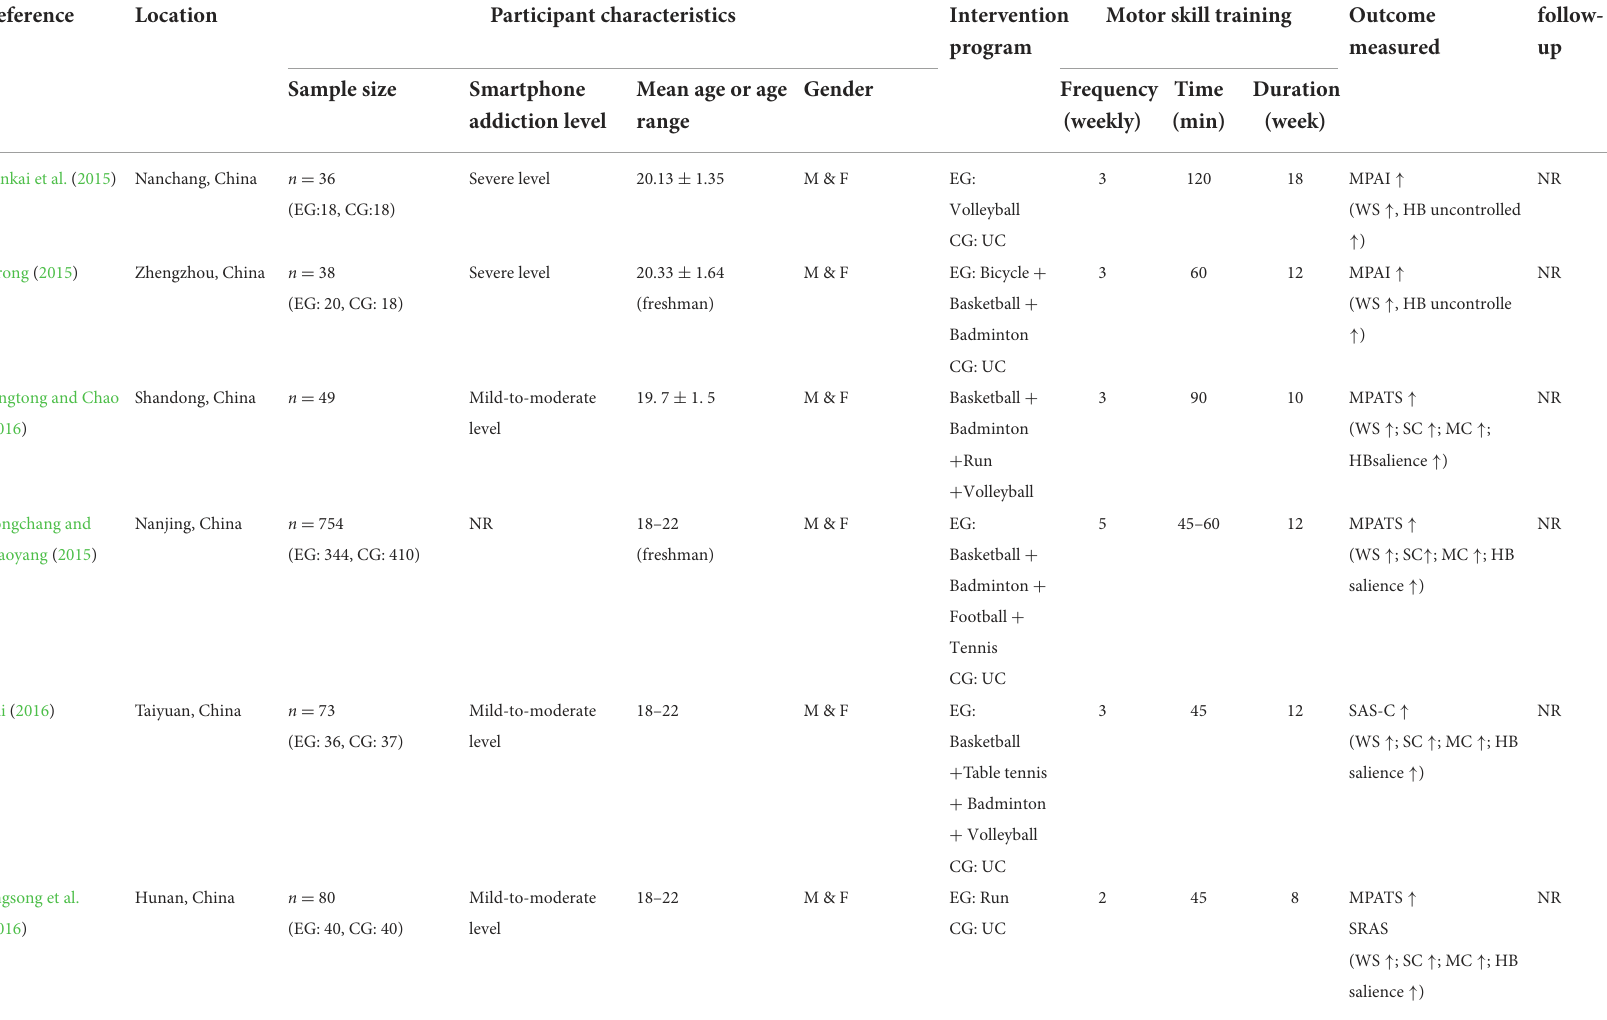
TABLE 2 Overview of exercise intervention with smartphone